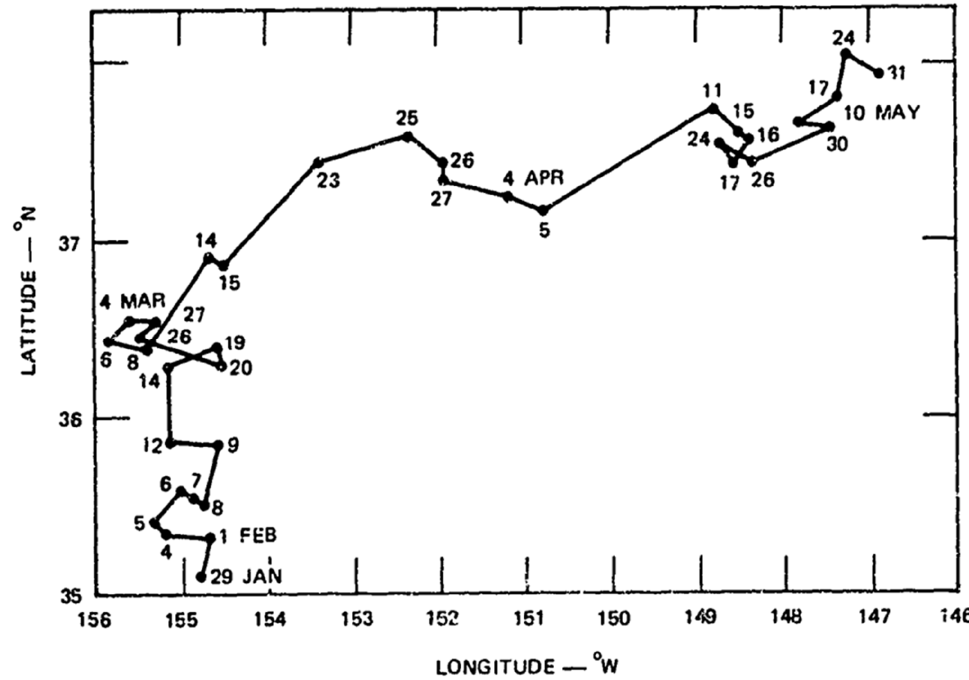
Figure 44. WARF skywave radar track of a buoy fitted with a repeater recorded over four months in 1974; note the rapid changes in direction and loops [35].